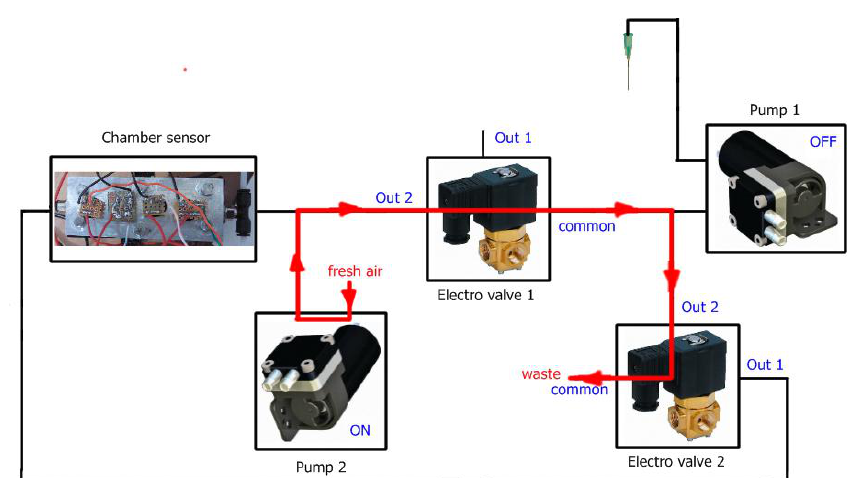
Figure 5. Flow of gases at the cleaning2